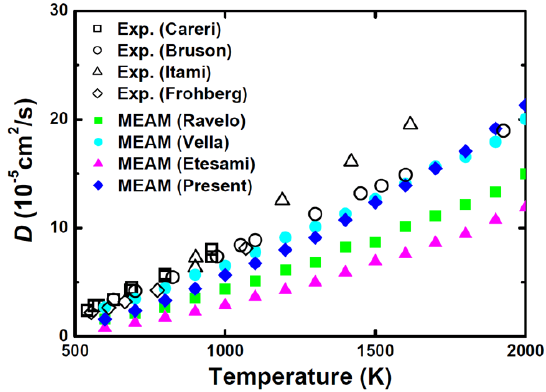
Figure 7. Calculated self-diffusivity of liquid Sn using the present 2NN MEAM potential, in comparison with experimental data (Refs. [49–52]) and the calculation results using previous MEAM potentials by Ravelo and Baskes [5], Vella et al. [12], and Etesami et al. [13].